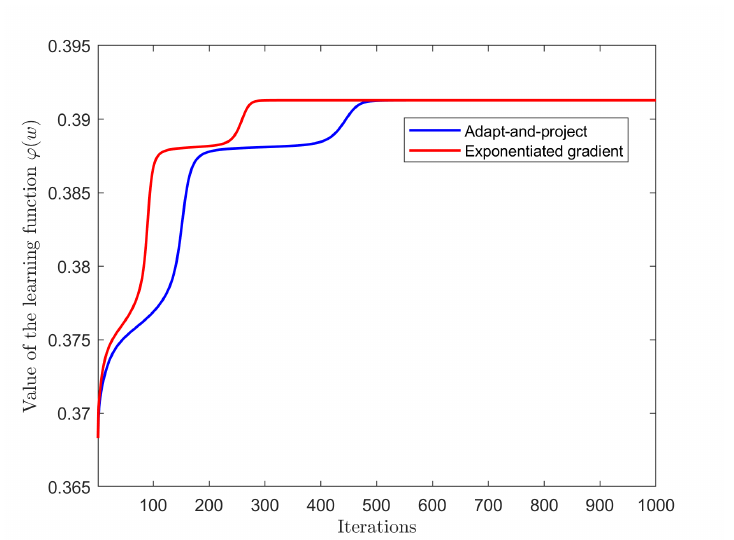
Figure 24. Comparison of learning curves of AAP and EG for a value of the learning step size µ = 2 10 − 4 ×